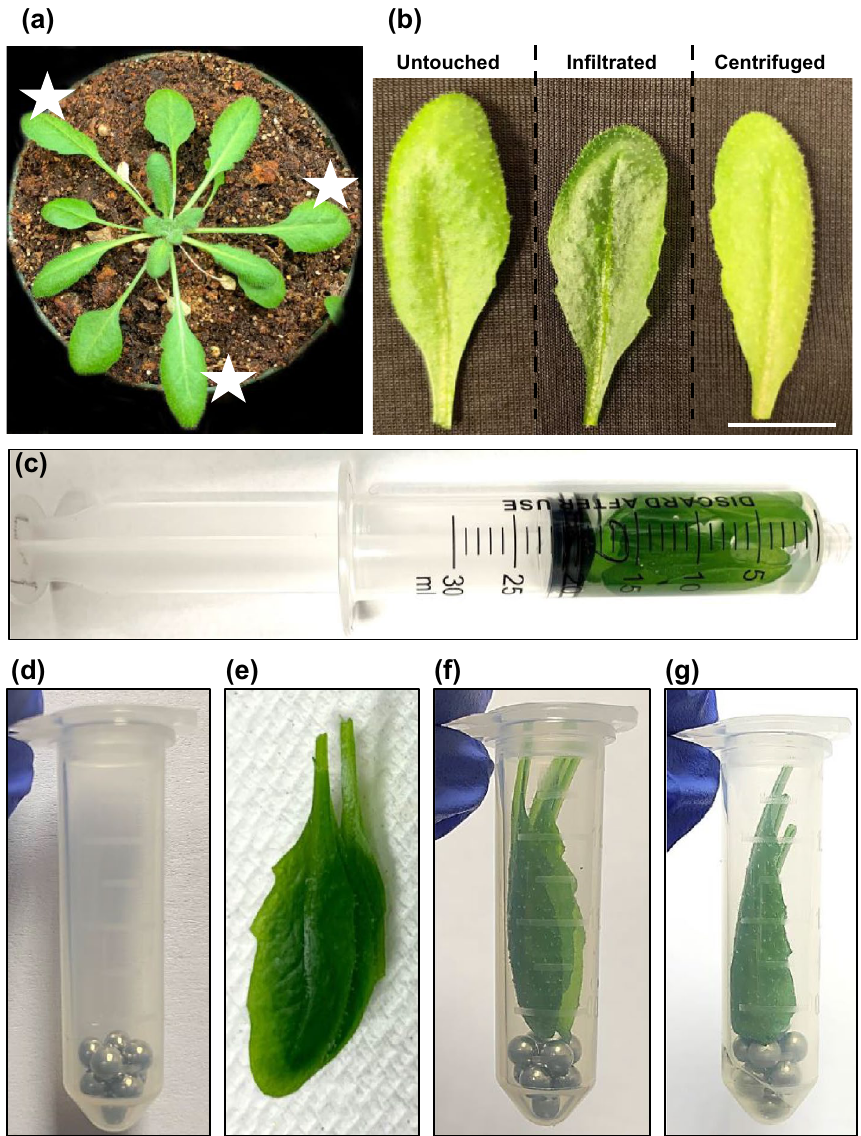
Figure 1. Procedure for Arabidopsis apoplast extraction. ( a ) Three leaves from 5 week-old Arabidopsis plants at a similar developmental stage (stars) were used for the assay. ( b ) Representative images of untouched, vacuum- infiltrated and centrifuged leaves (Bar = 1 cm). ( c ) Nine leaves were harvested from three plants and vacuum- infiltrated with apoplast wash fluid in a 30 cc syringe. ( d ) Two mL tube with nine 3.2 mm metal beads. Three vacuum-infiltrated leaves were blotted dry and nested together ( e ) and inserted into a 2 mL tube with metal beads ( f ). ( g ) Two mL tube with leaves after the